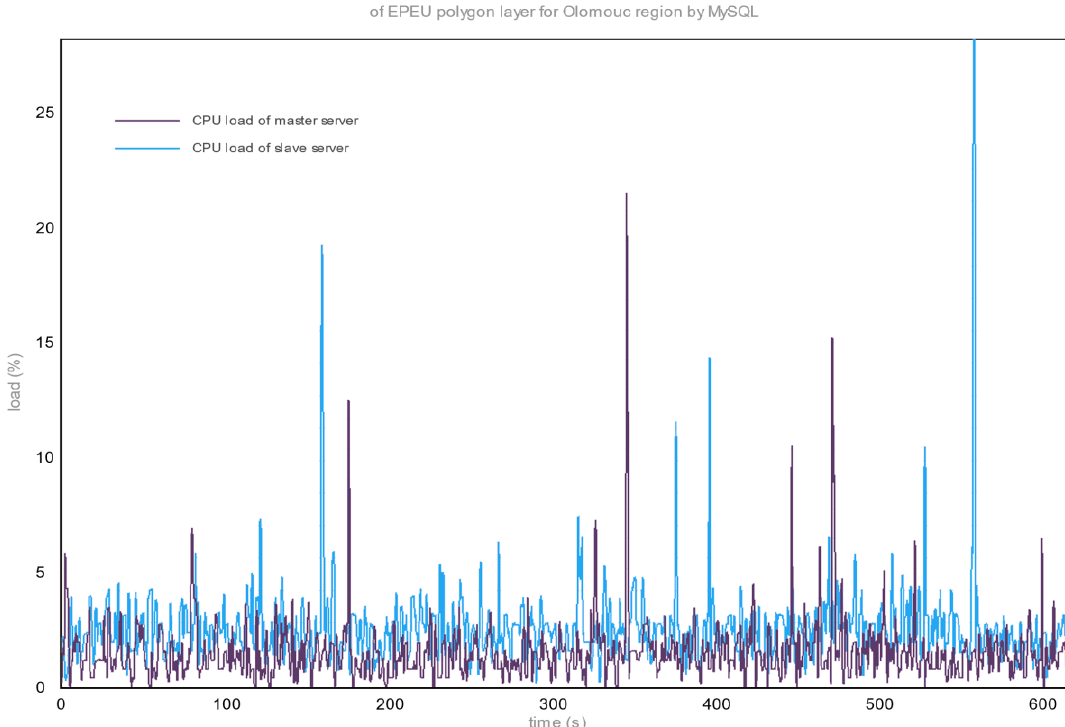
Figure 2. Average CPU load during replication of the EPEU layer by MySQL.